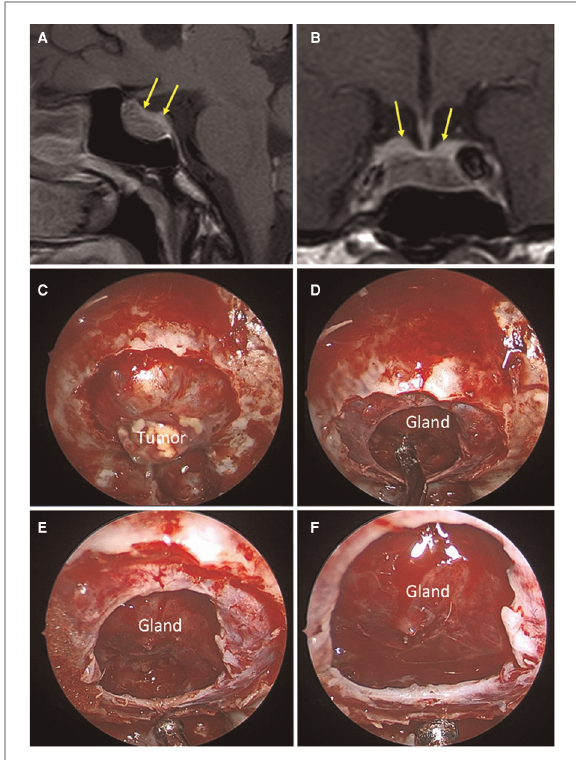
FIGURE 1 Strong sellar barrier. A 42-year-old male patient, with GH produce macroadenoma. ( A,B ) Preoperative MRI: the yellow arrows indicate the barrier that captures contrast with a thickness greater than 1 mm. ( C – F ) Intraoperative images: the barrier constituted by the gland can be seen.